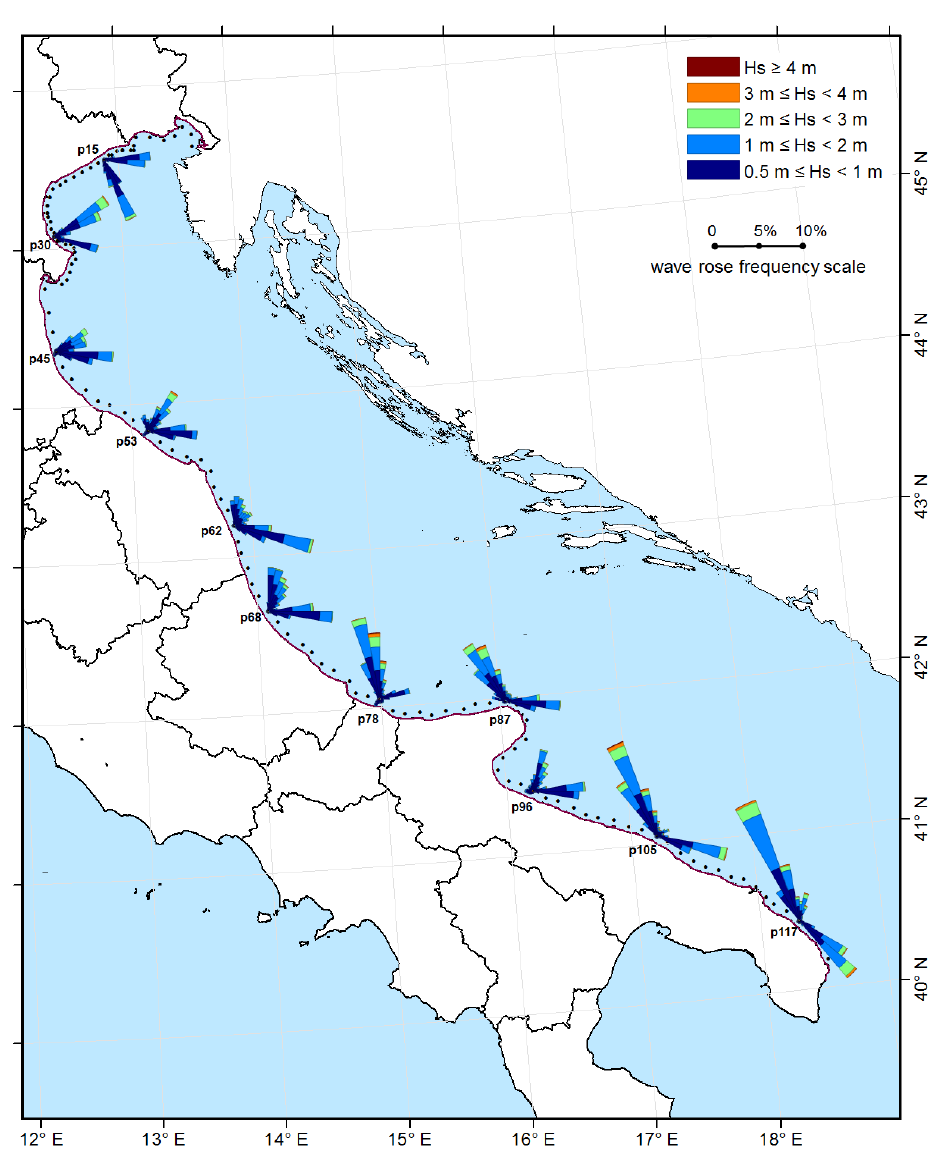
Figure 2. Wave roses in some of the 120 virtual wave buoys along the Adriatic coast of Italy relative to the historical run (1981–2010) highlighting the main wave direction along the coast.